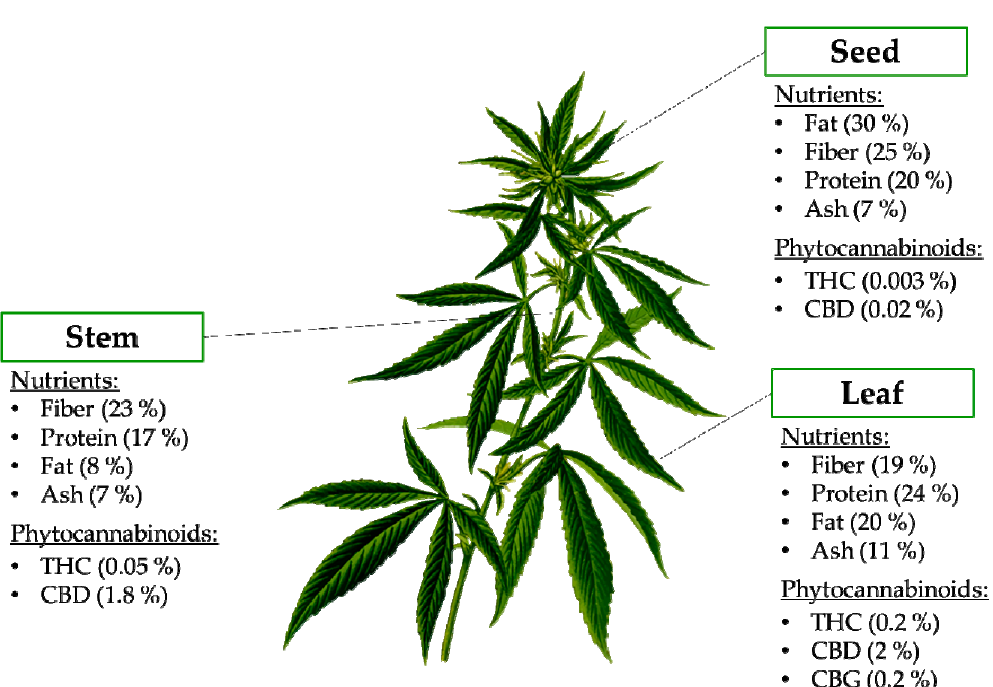
Figure 2. Nutritional composition and phytocannabinoids present in the different anatomic parts of the hemp plant. Abbreviations: CBD, cannabidiol; CBG, cannabigerol; THC, Δ 9 -tetrahydrocannabinol.